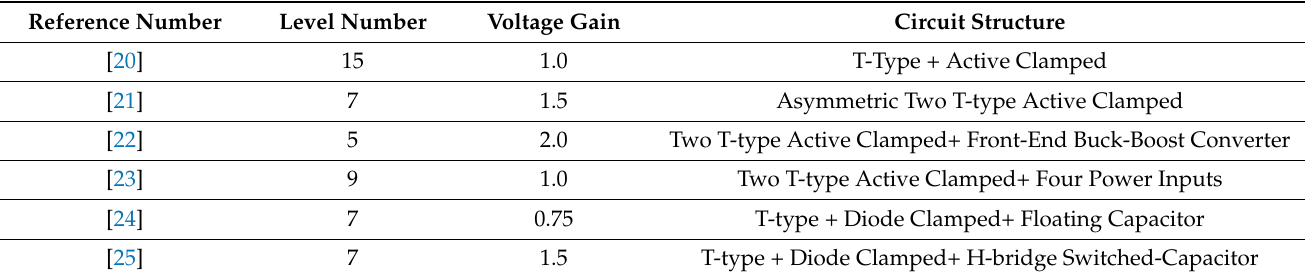
Table 1. T-type single-phase